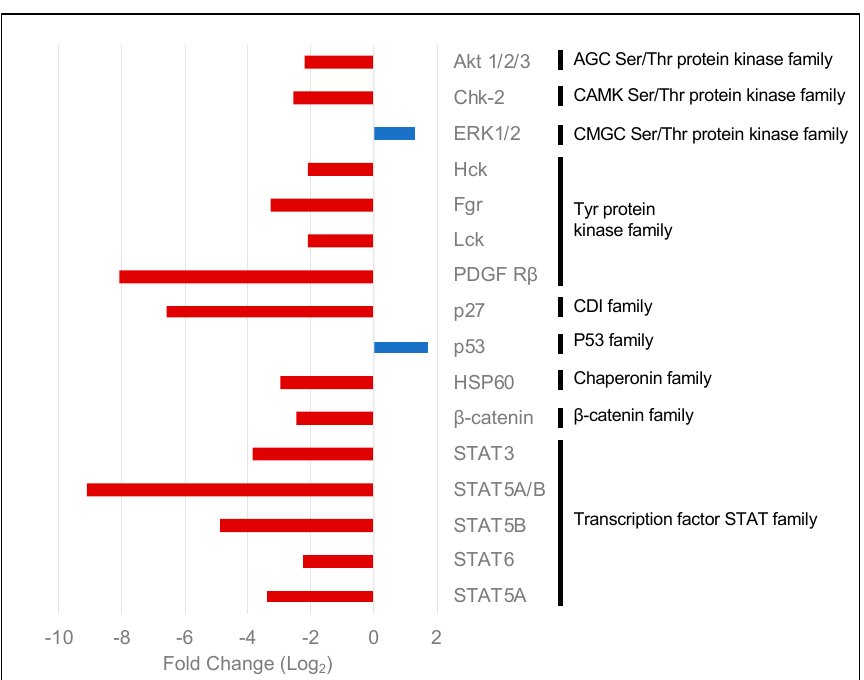
Figure 4. Human phospho-kinase array comparing PKC α -KD vs. PKC α -WT MCF-7 cells. The histogram shows the fold changes of the kinases affected by the down-regulation of the expression of PKC α in MCF-7 cells. Red bars represent phosphorylated proteins showing a decrease in phosphorylation levels, whereas blue bars show an increase.